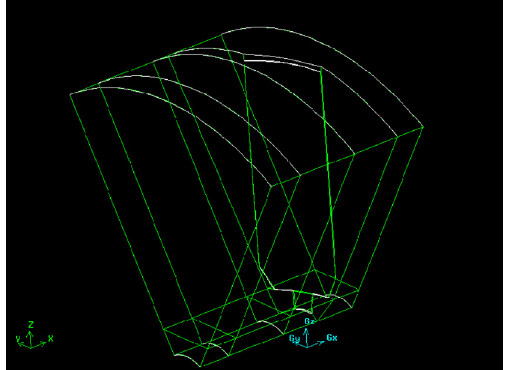
Figure 12: Static pressure distribution on suction side of a fan blade without radiator (unit in Pascal).